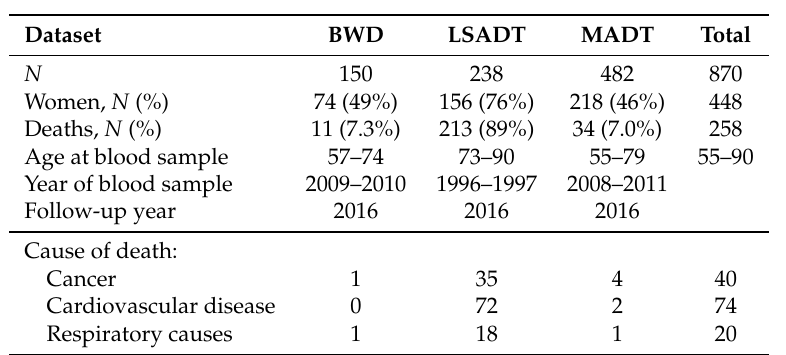
Table 1. Characteristics of the sample population. Cardiovascular diseases include apoplexy and age-related cardiovascular